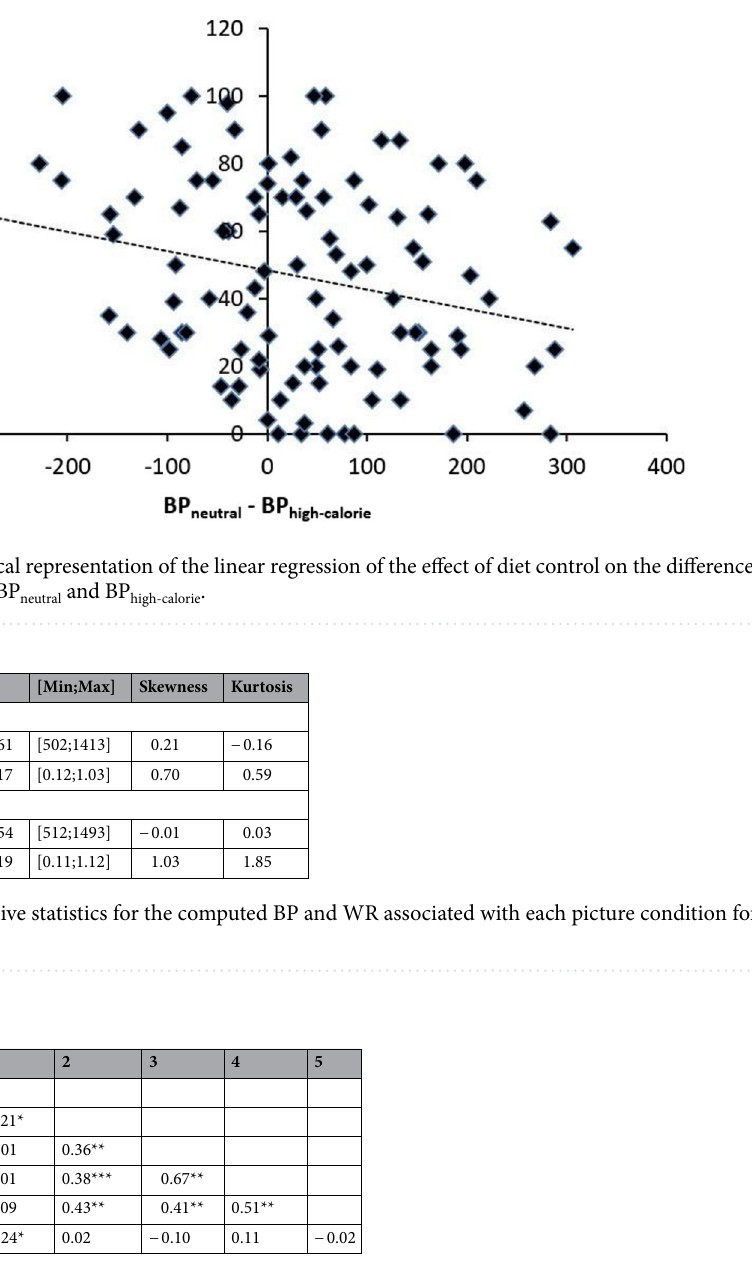
Table 5. Correlation matrix of the distortion observed on p(long) differences over the three last durations and Bisection Points, on Arousal, Valence, Craving, Hunger, and Diet Control. Note: †p < 0.01; *p < 0.05; **p < 0.01.